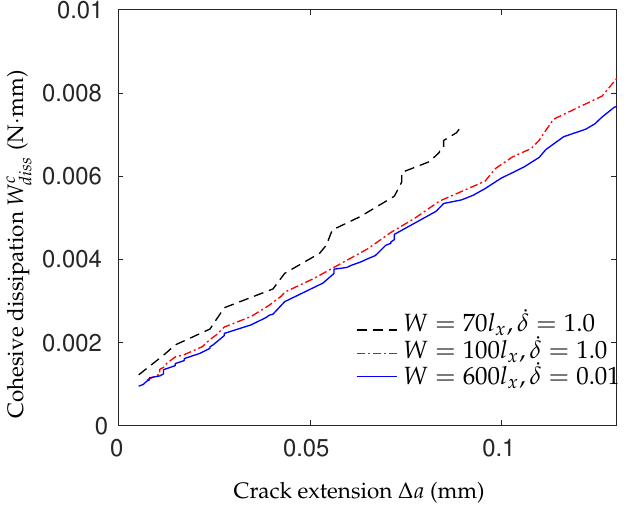
Figure 11. Cohesive dissipation for three cases: W = 70 l x and ˙ δ = 1.0 m/s, W = 100 l x and ˙ δ = 1.0 m/s and W = 600 l ˙ δ = 0.01 m/s x and